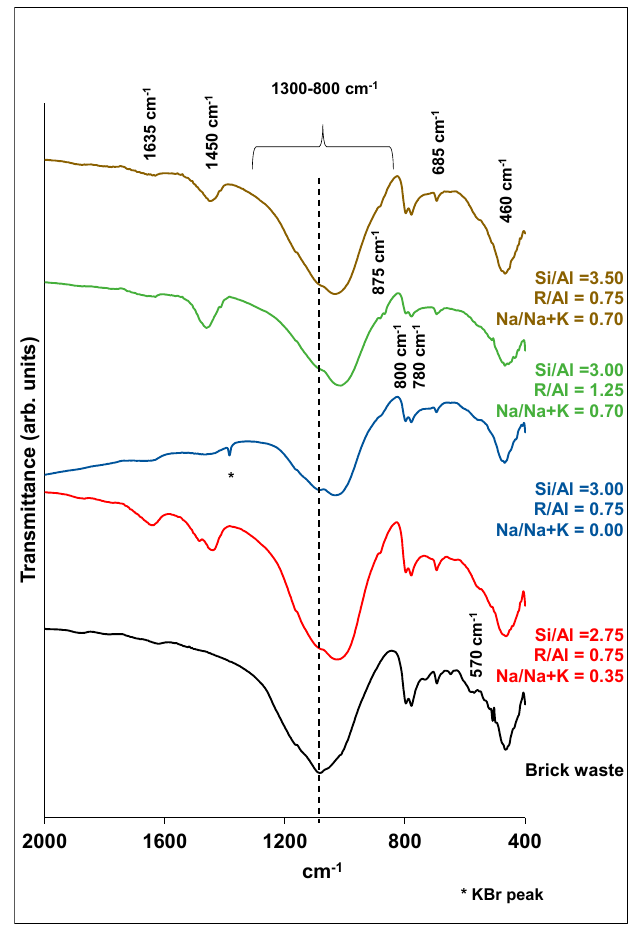
Figure 7. FTIR spectra of brick precursor and selected brick geopolymers.